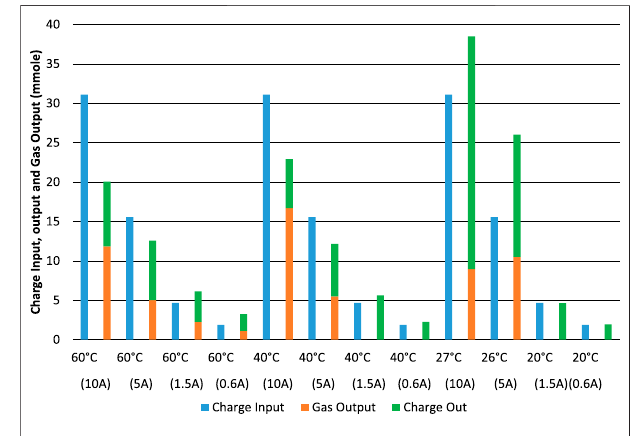
FIGURE 8 | Electrolysis total gas production rates vs. cell voltage averaged over the test. Cells had 1.25 mm spacers each side of the membrane.